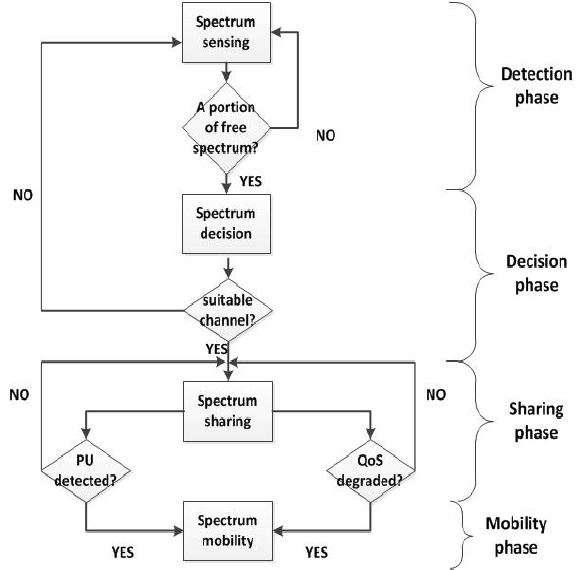
Spectrum sensing: The spectrum sensing is defined